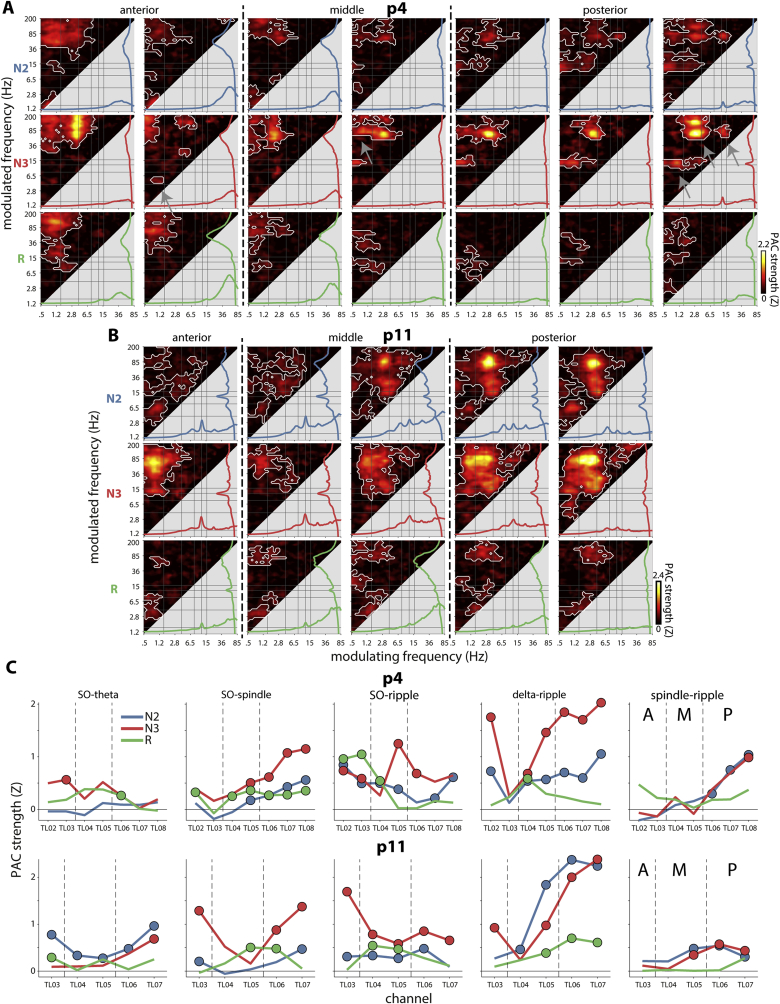
Phase-amplitude coupling along hippocampal axis for example patients. (A and B) Coupling strengths for all HPC contacts in two example patients. White outlines indicate clusters of significantly higher than zero coupling (P < 0.05, cluster-based permutation test). (C) Coupling strengths for five frequency pairs, indicated in (A) with arrows. Presence of marker indicates frequency pair is part of significant cluster in (A) or (B). Dashed lines separate anterior (A), middle (M), and posterior (P) channels.